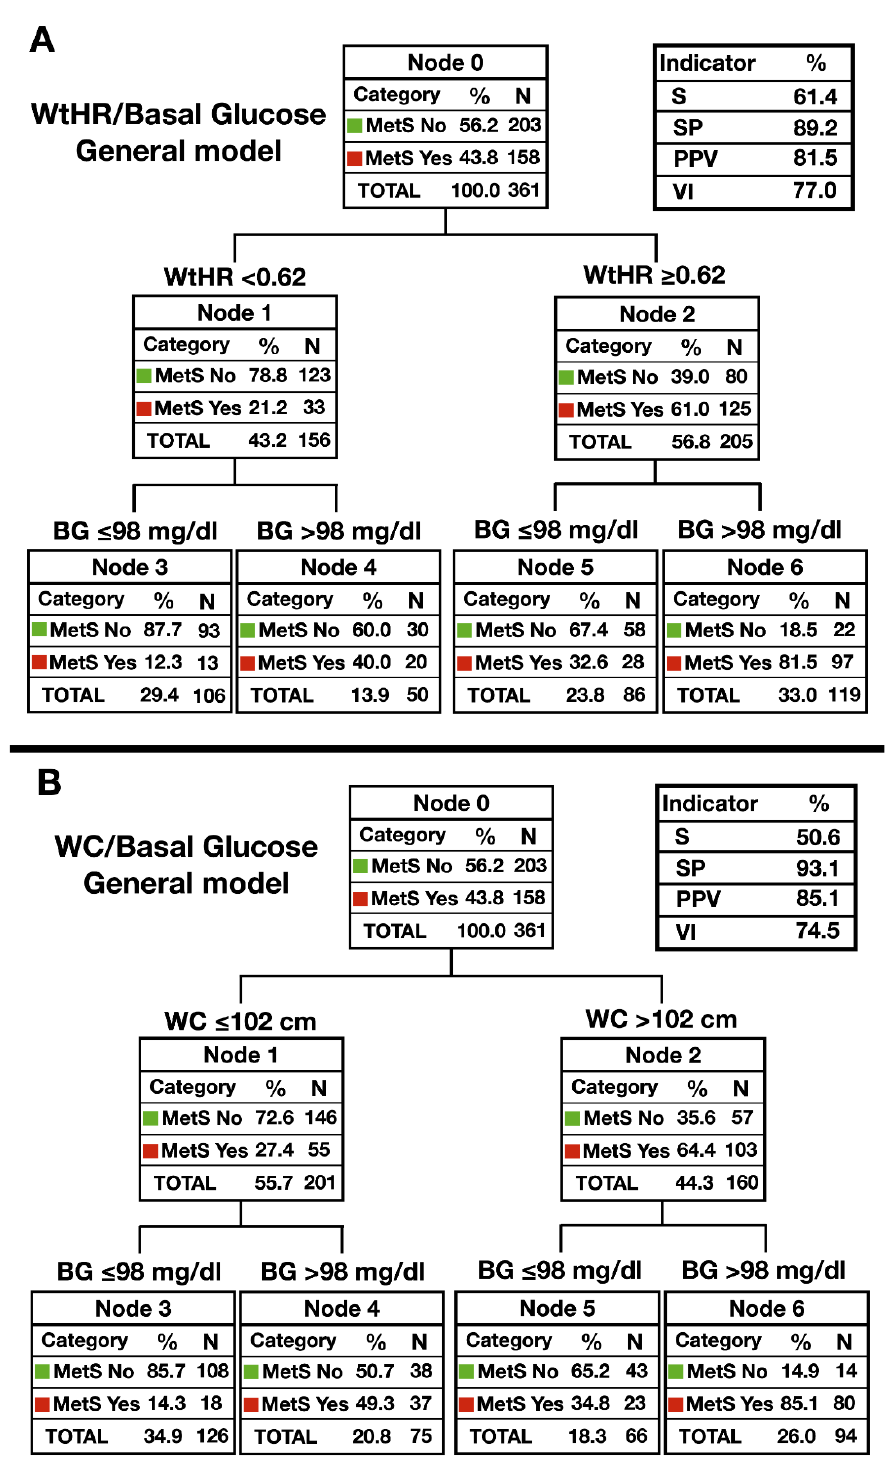
Figure 2. Diagnostic decision trees for detection of MetS in the elderly ( n = 158). ( A ) Model that uses WtHR and basal glucose in the total sample; ( B ) Model that uses WC and basal glucose in the total sample. MetS: metabolic syndrome; WtHR: waist–height ratio, WC: waist circumference, BG: basal glucose. S: sensibility; SP: specificity; PPV: positive predictive value; VI: validity index.